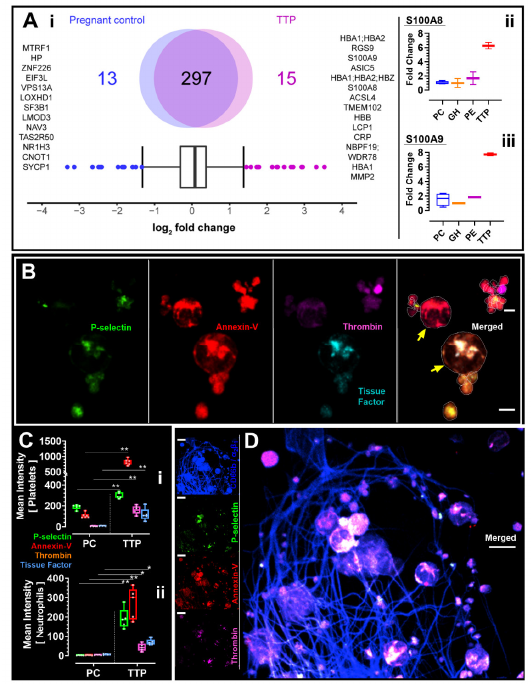
Figure 1. Platelet Proteomics and Procoagulant Membrane Dynamics Study in a Case of Congeni- tal TTP Complicated by Fetal Demise.